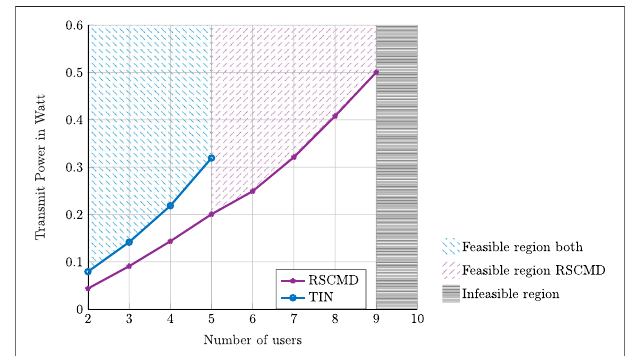
FIGURE 6 | The optimal value of the optimization problem (P 2 ) as a function of the number of users. We compare the performance of TIN and RS – CMD transmission